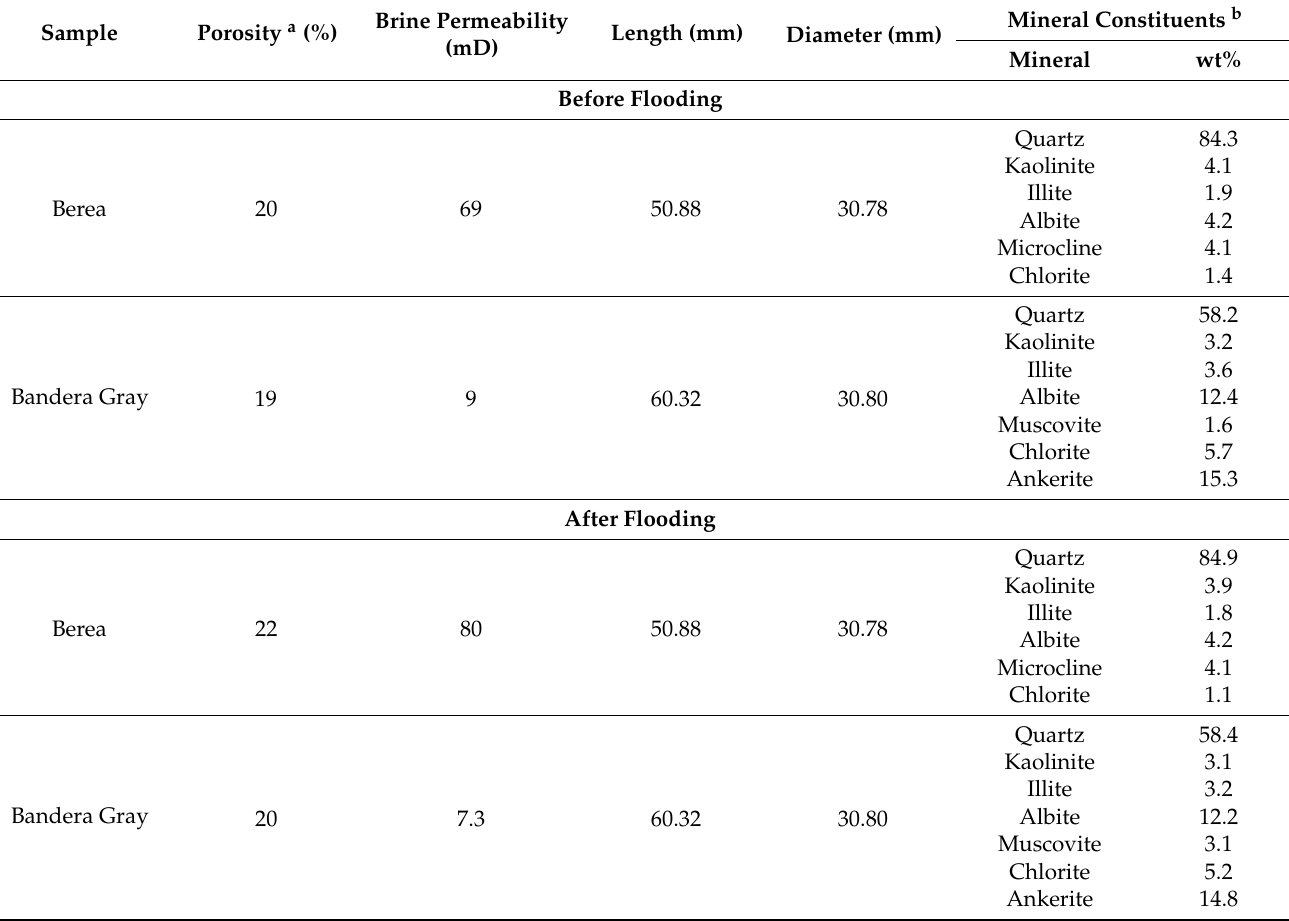
Table 1. Petrophysical and mineralogical sandstone